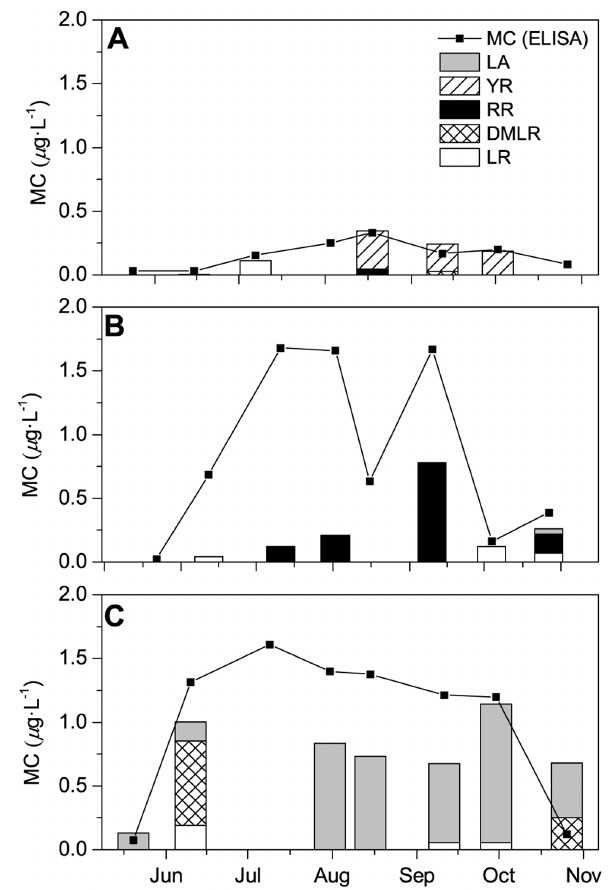
Figure 3. Temporal variation of total MC concentration measured by ELISA (full squares) and MC congeners measured by HPLC (stacked bars), from May to October in the three study lakes. A) Lake Bromont, B) Waterloo, and C) Petit Lac St. Franc¸ois.